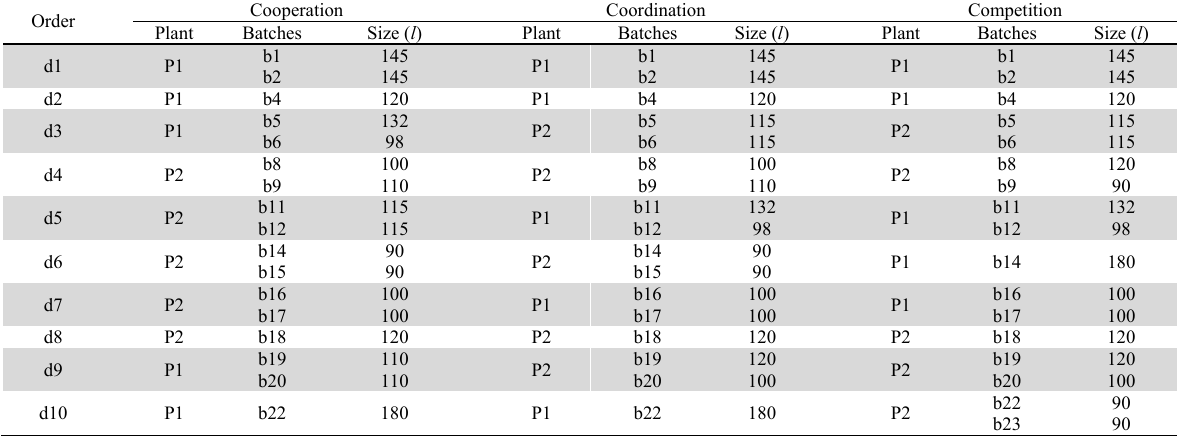
Selected plant and batch sizes for each order and each operational policy at Example 1